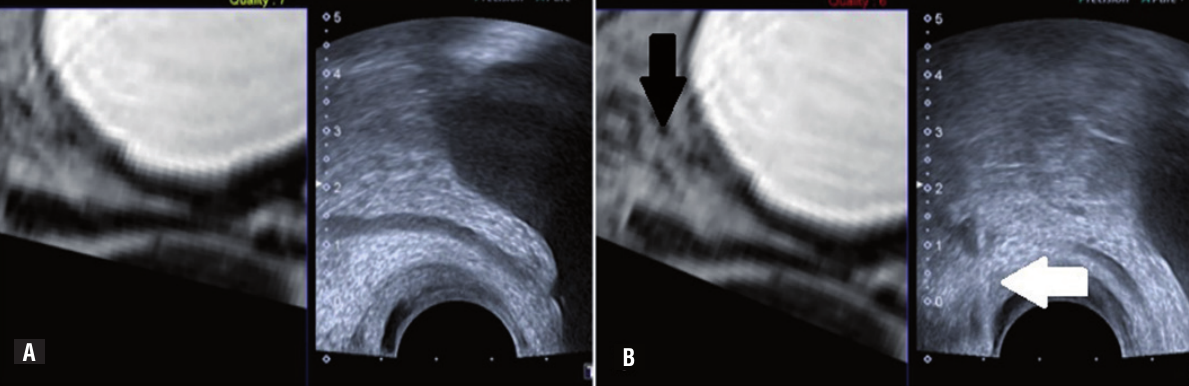
Figure 2 - A) Tomography and ultrasound images fusion, showing images synchronization. B) On the left, arrow (black) shows the position of the thickened vas deferens (CT); on the right, the biopy needle into the target lesion (white arrow).